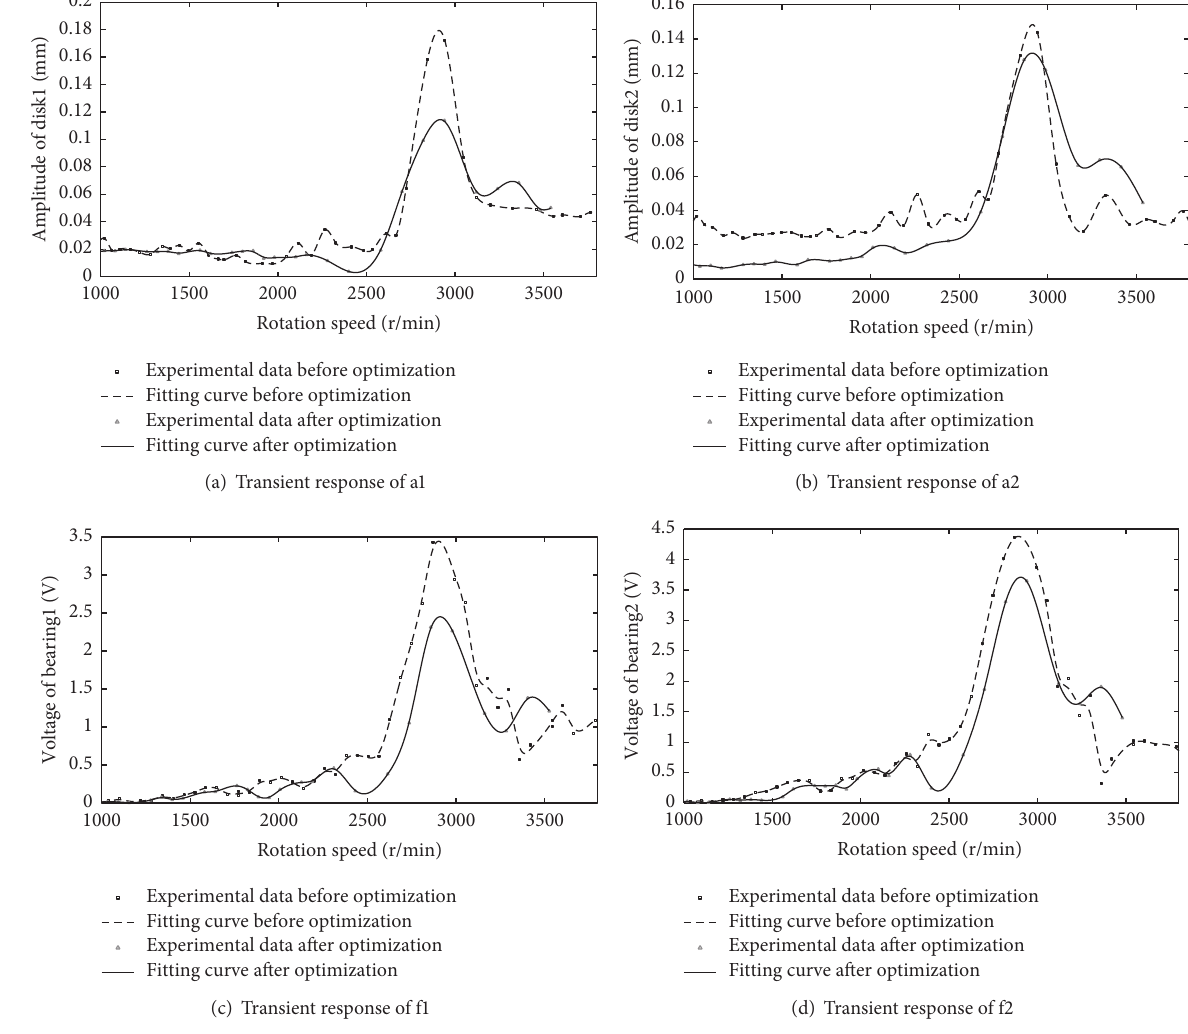
Experimental data before optimization Fitting curve before optimization Experimental data after optimization Fitting curve after optimization